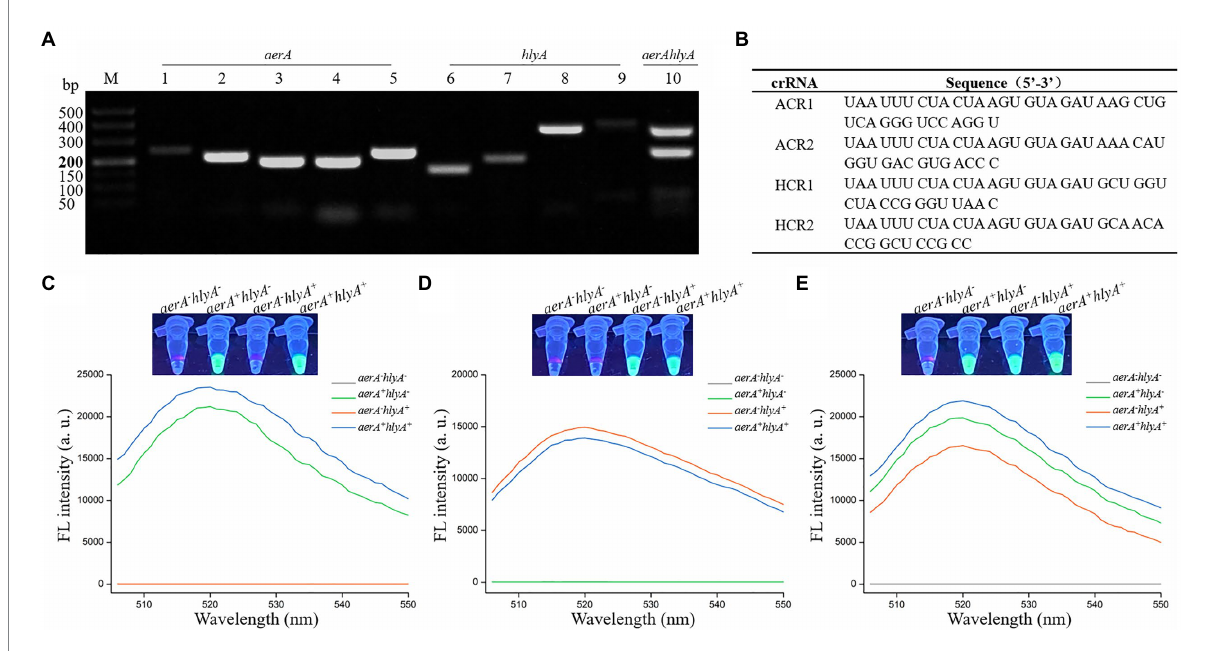
FIGURE 2 Feasibility verification of the dRAA-CRISPR/Cas12a assay in the detection of Aeromonas hydrophila . (A) Screening the RAA primer pairs. The single and dualplex RAA assays were performed using the genomic DNA extracted from aerA + hlyA + A. hydrophila strain as the template. Lanes 1–5, screening the primer pair targeting for aerA gene. Lanes 6–9, screening the primer pair targeting for hlyA gene. Lane 10, feasibility of dRAA assay with the optimal aerA and hlyA primer pairs. (B) Sequences of crRNA used in this study. (C–E) Feasibility verification of the dRAA-CRISPR/Cas12a assay using the ACR1 and ACR2 (C) , HCR1 and HCR2 (D) , and ACR1, ACR2, HCR1 and HCR2 (E) in the detection of four A. hydrophila strains. Fluorescence signals were read using an UV flashlight (upper) or a multifunctional microplate reader